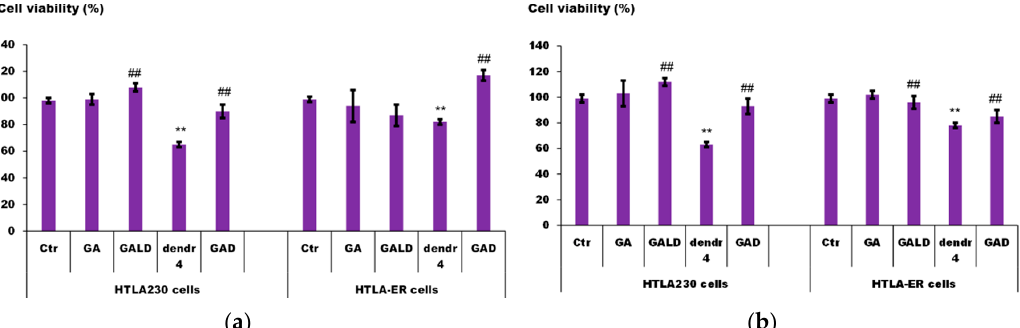
Figure 12. Viability (%) of HTLA-230 and HTLA-ER cells treated with GA, GALD, and GAD. The analysis was performed by CellTiter 96 ® Aqueous One Solution Cell Proliferation Assay in HTLA-230 and HTLA-ER cells exposed to dendrimer 4 at the known active concentration (0.169 µM), GALD (in a dose capable of providing 0.169 µM dendrimer 4 ), 21.20 µM GA (the dose provided by GALD used), and GAD in a dose capable to provide 21.20 µM GA for: 48 h ( a ); and 72 h ( b ). Histograms summarize quantitative data of the means ± S.E.M. of three independent experiments. ** p < 0.01 vs. Ctr cells; ## p < 0.01 vs. dendrimer 4 -treated cells.